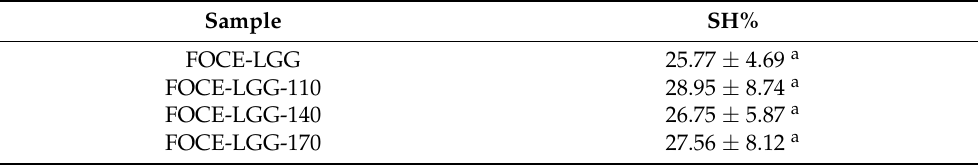
Table 5. Surface hydrophobicity of FOCE-LGG